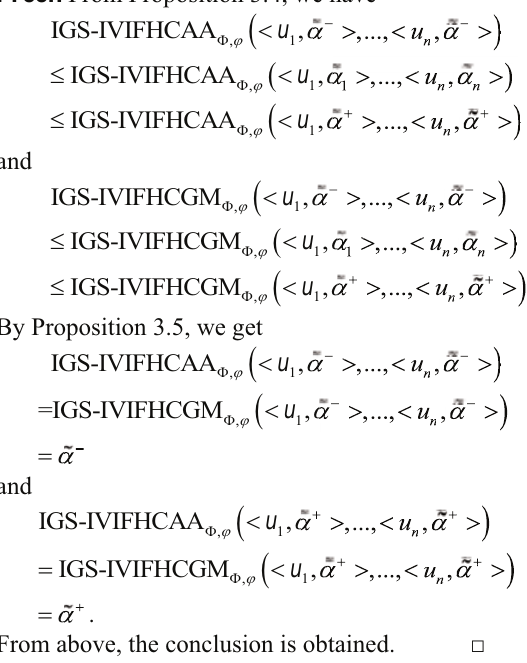
comprehensive interval-valued intuitionistic fuzzy